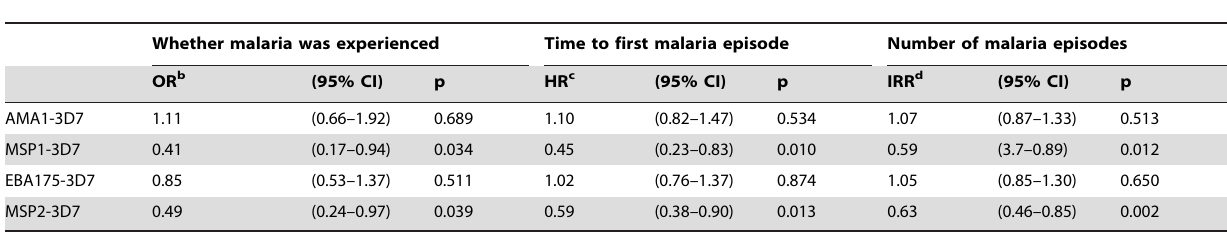
Table 1. Results of multivariate regression analysis adjusted for age and Hb type a